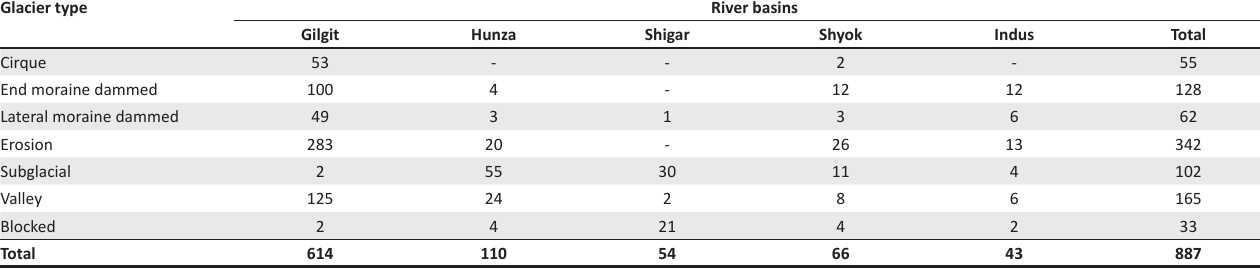
TABLE 2: Summary of the different types of glacial lakes in the Karakoram Range, Pakistan. Glacier